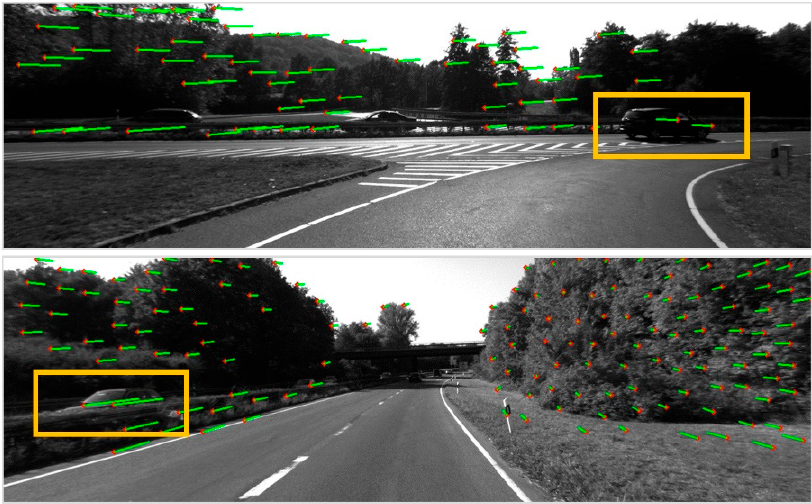
Figure 3. Example of moving objects in image. Top: sequence 01; frame 07. Bottom: sequence 01; frame 46.